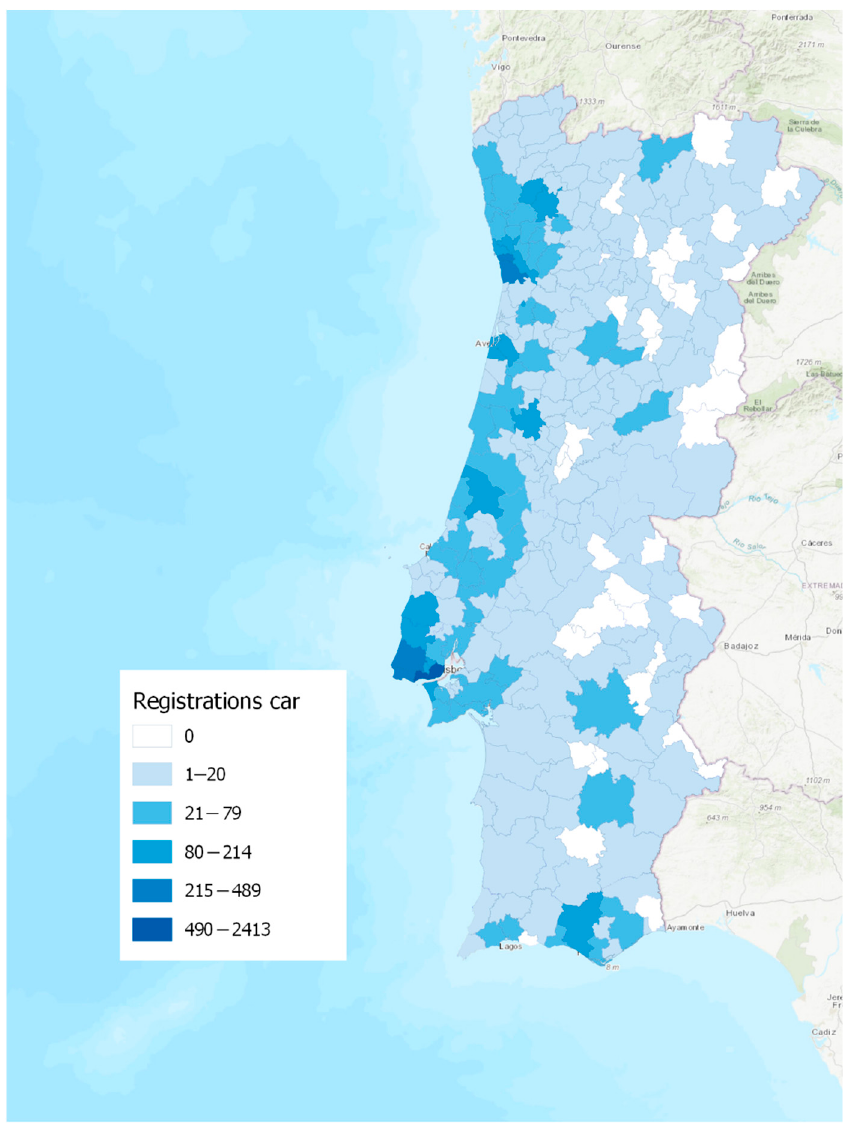
Figure 8. BEVs registered until June 2018 in Portugal (Map elaborated with QGIS).